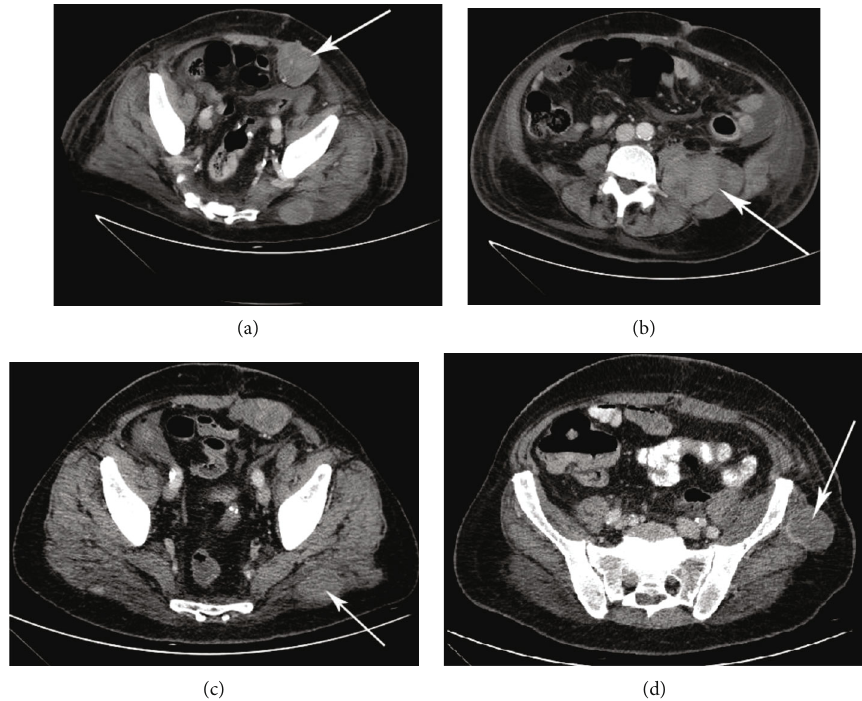
Figure 3: A CT scan following the surgery showed multiple residual tumors in the lower abdomen and pelvis. (a) Front abdominal wall. (b) Psoas muscle. (c) Gluteus. (d) Iliac